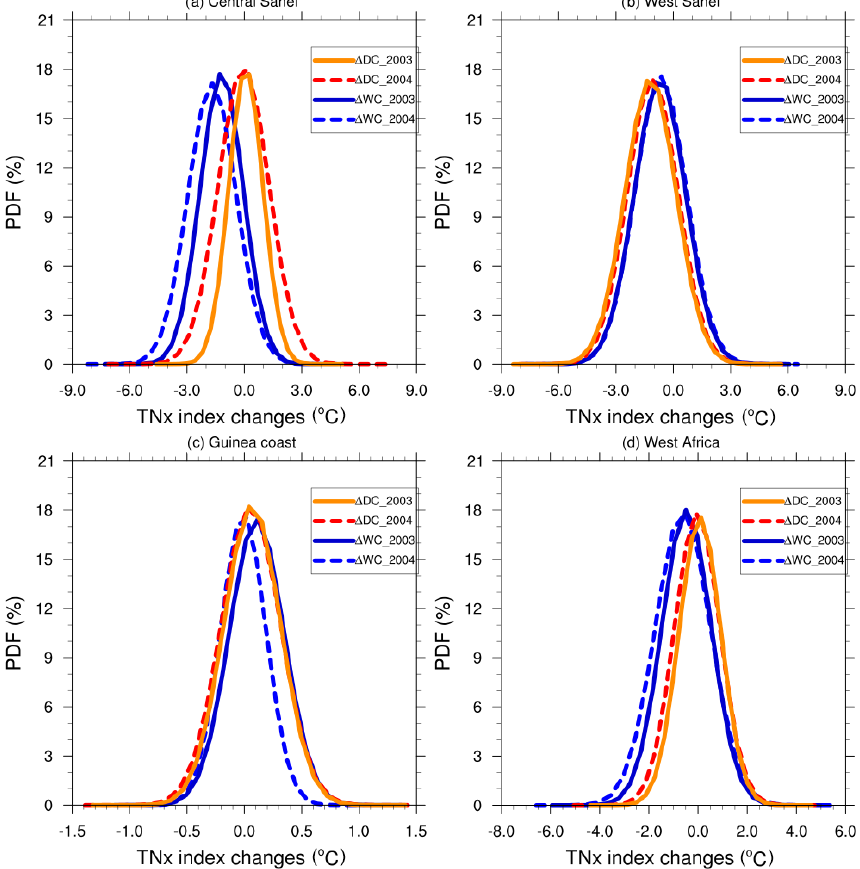
Figure 21. Same as Fig. 15 but for the TNx